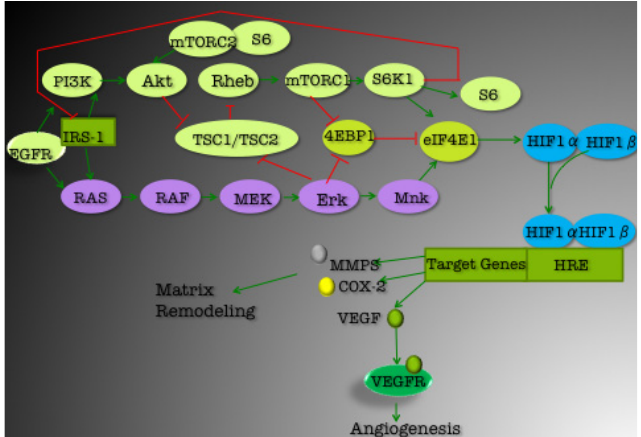
Figure 2. Diagram of PI3K/Akt and Ras/Raf pathway (see text for